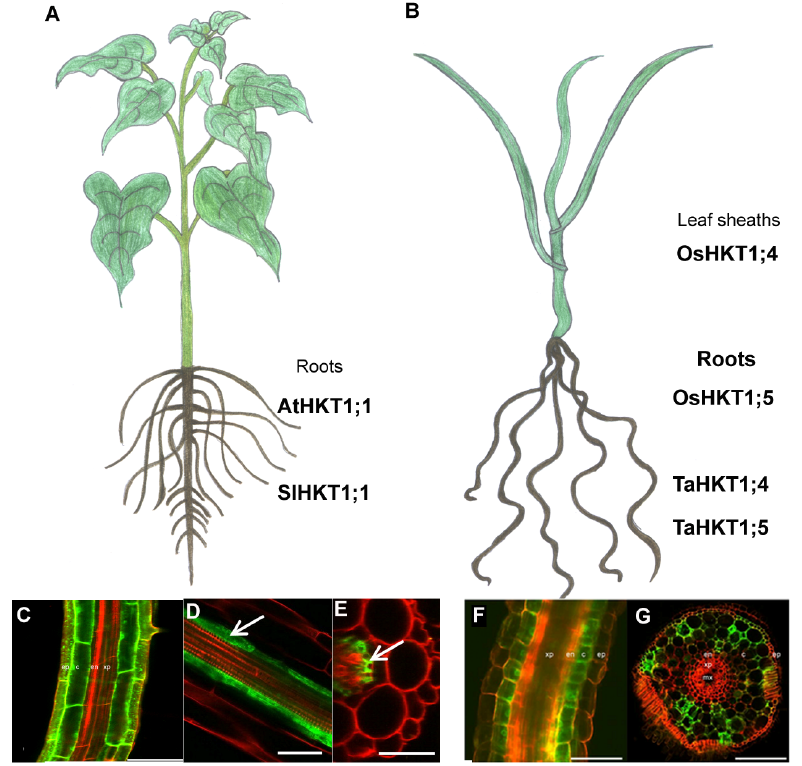
Figure 3. Targeted expression of AtHKT1;1 in the roots of both ( A ) dicotyledonous and ( B ) monocotyledonous plants. The targeted over-expression of AtHKT1;1 in the roots, regardless of the tissue as both over-expression in the ( C ) epidermal and cortical cells as well as ( D and E ) in the pericycle, resulted in enhanced salinity tolerance in Arabidopsis thaliana plants. Also in rice the overexpression of AtHKT1;1 in the ( F and G ) epidermis and cortical cells resulted also in enhanced salinity tolerance. This might be a useful strategy to use with other HKT genes to ameliorate the salt sensitivity of crop species. Bars: ( C ) 75 μ m, ( D and E ) 40 μ m, ( F and G ) 100 μ m. Figure 3C,F,G reproduced with permission from [20]. Figures 3D,E reproduced with permission from